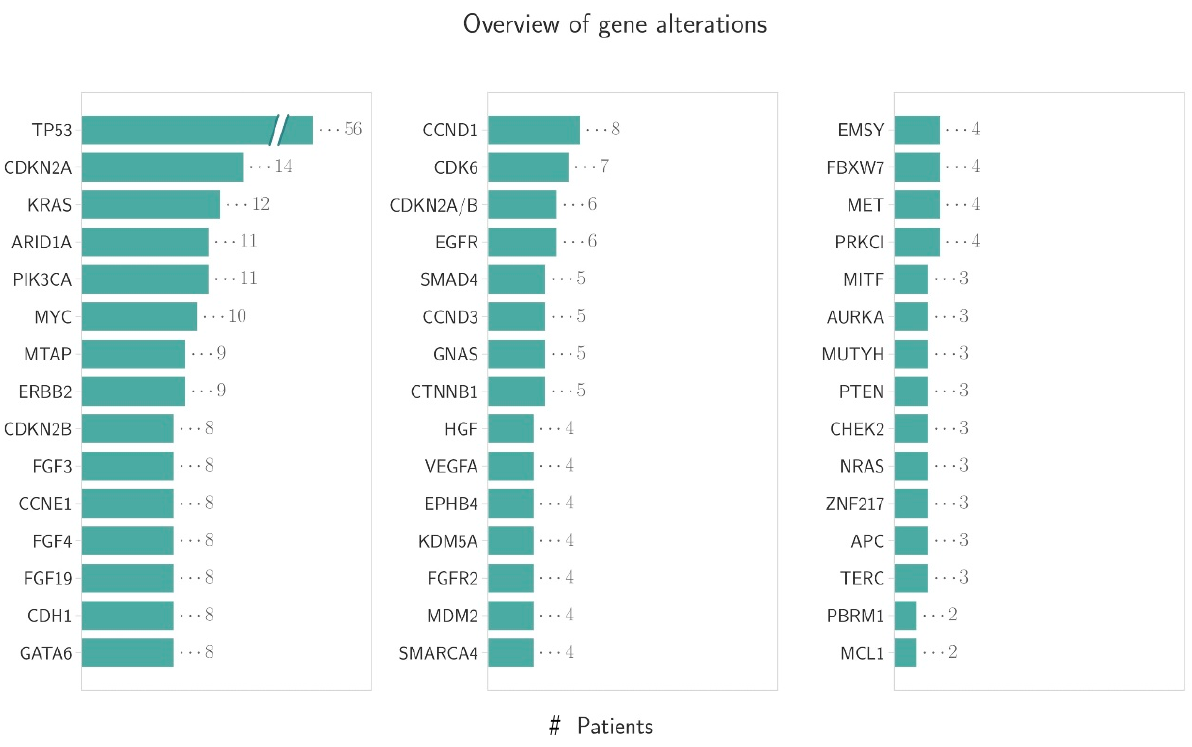
Figure 5. The number of detected alterations per patient (# indicates number of alterations).